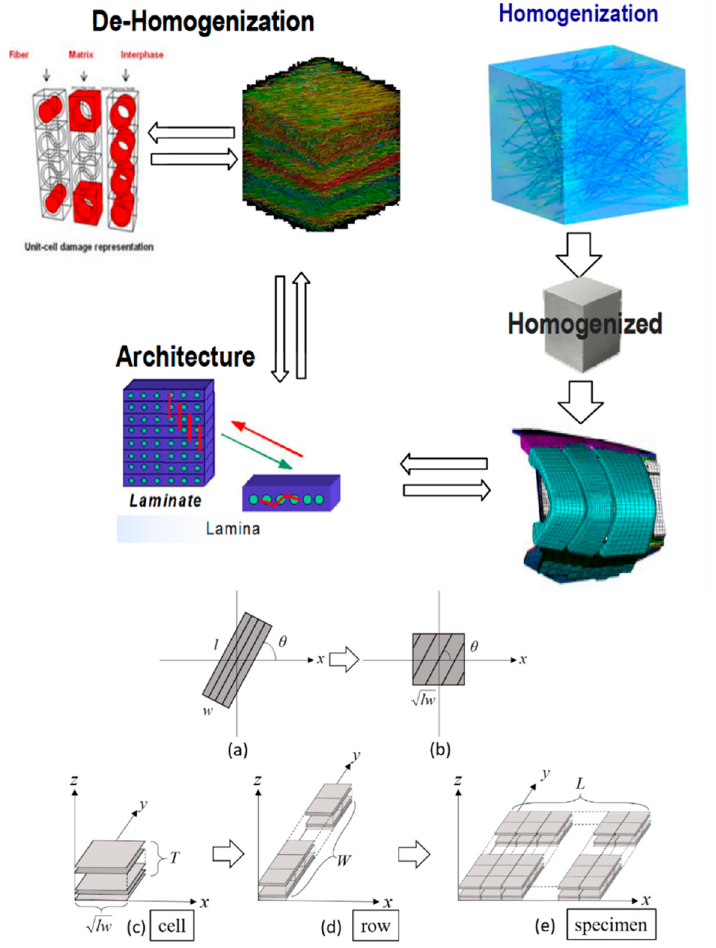
Figure 12. Mechanical modeling of CTT [25,40].